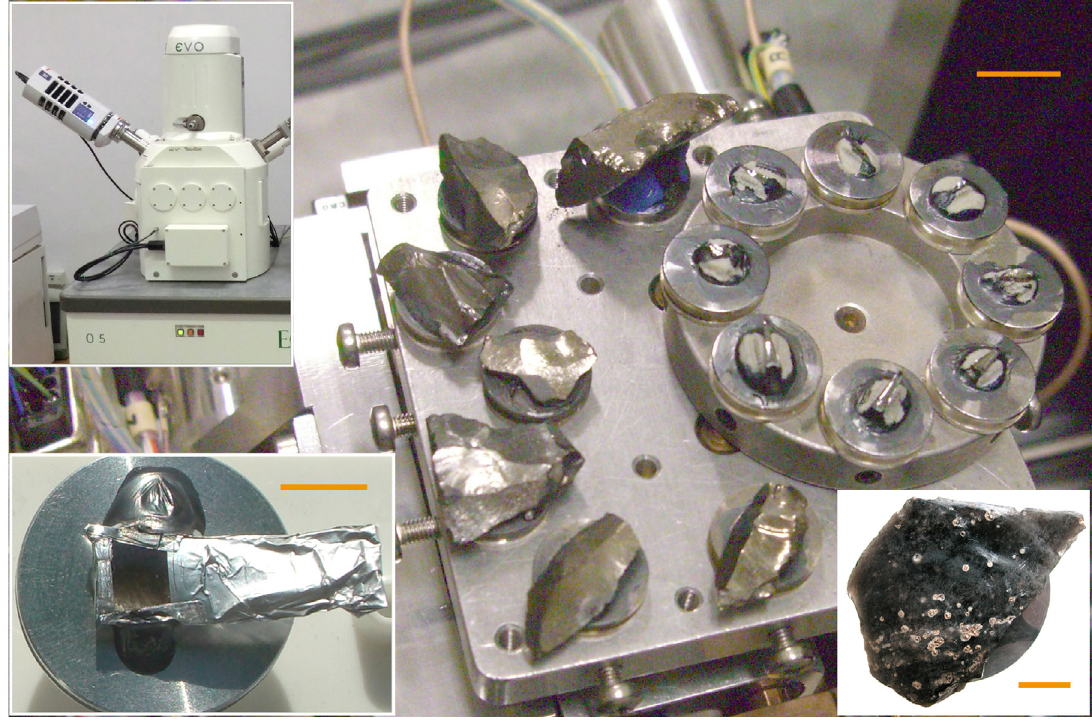
Figure 3: SEM-EDS analyses; up to 15 artefacts can be mounted on the sample older using plasticine (in blue color), silicone material (in grey color), conductive tape or colloidal graphite (in black color). In the left upper part of the figure is a